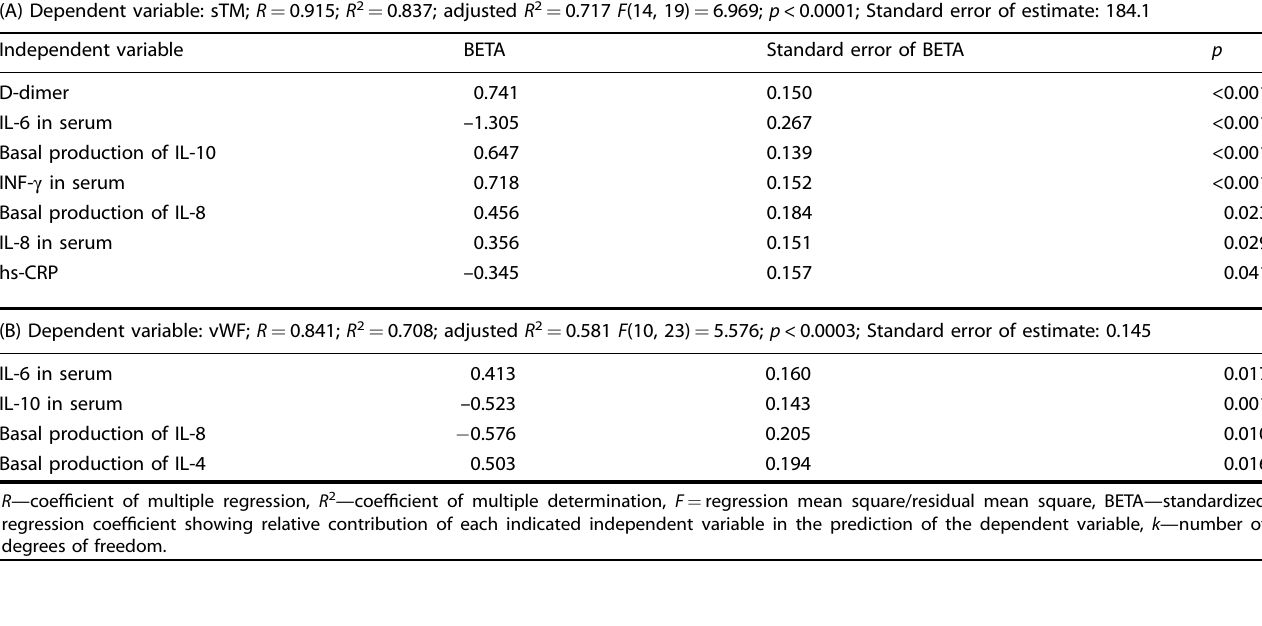
Table 3. Results of multiple regression analyses of cytokines and parameters of hemostasis in cosmonauts before and after space fl ights ( k = 27; forward stepwise regression, dependent variables sTM and vWF).